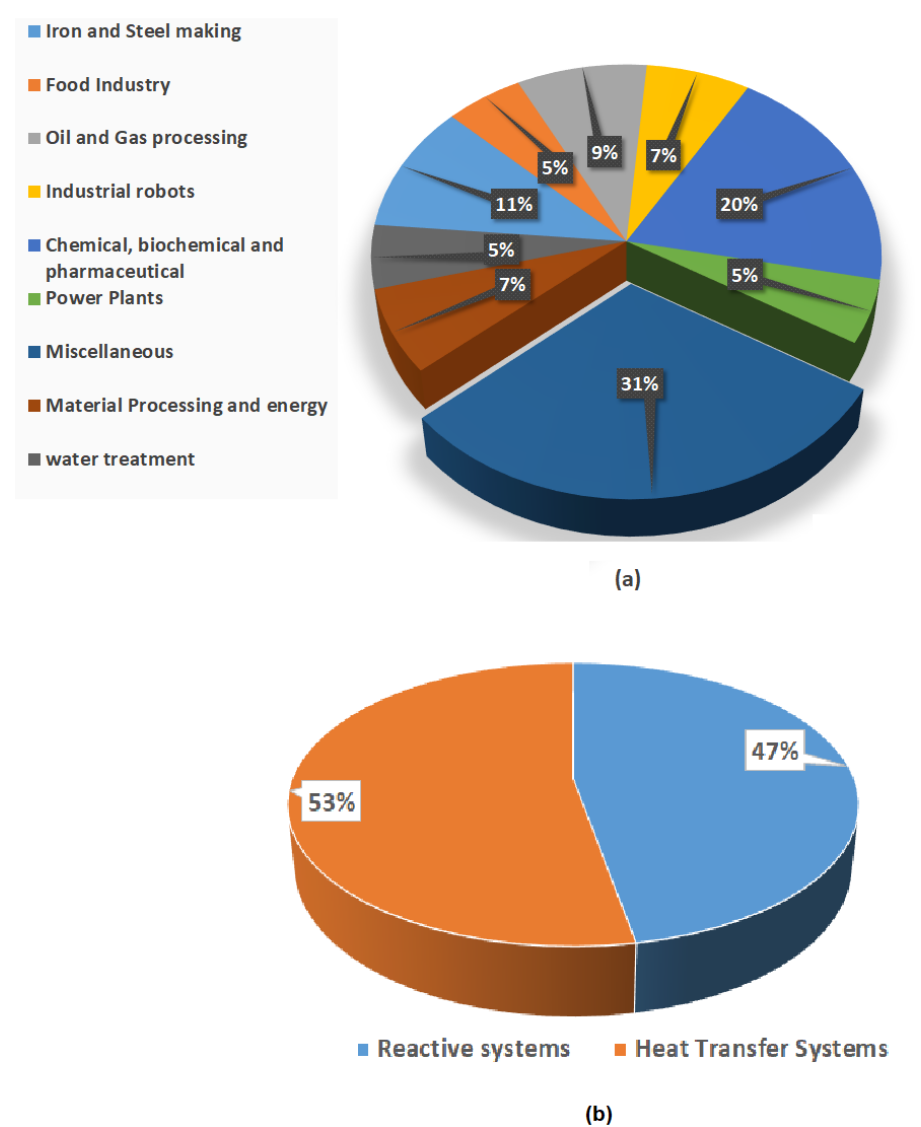
Figure 2. GB models in process industries in term of percentage share; ( a ) collective, ( b ) miscellaneous.